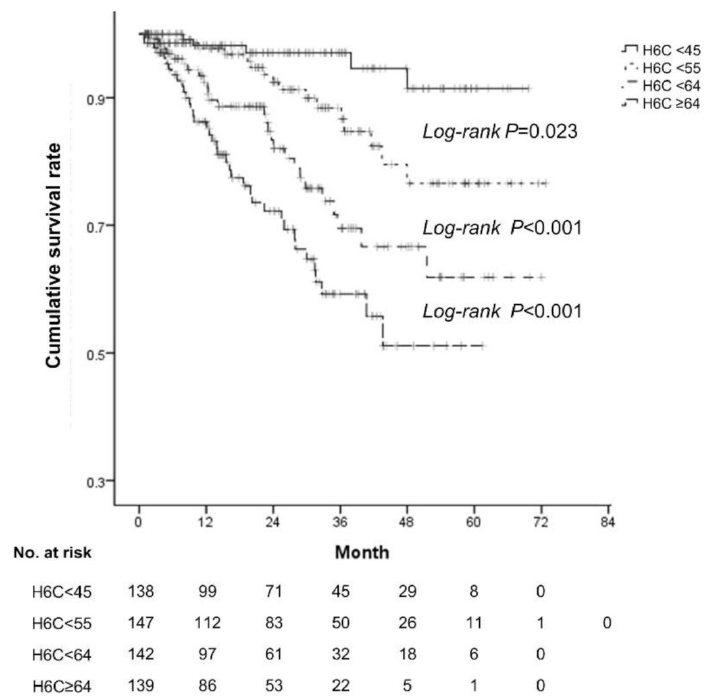
Figure 1. The cumulative survival rates according to the H6C score in the derivation cohort. The survival rates significantly di ff ered according to quartiles of the H6C score (shown as a continuous line and various dashed line).